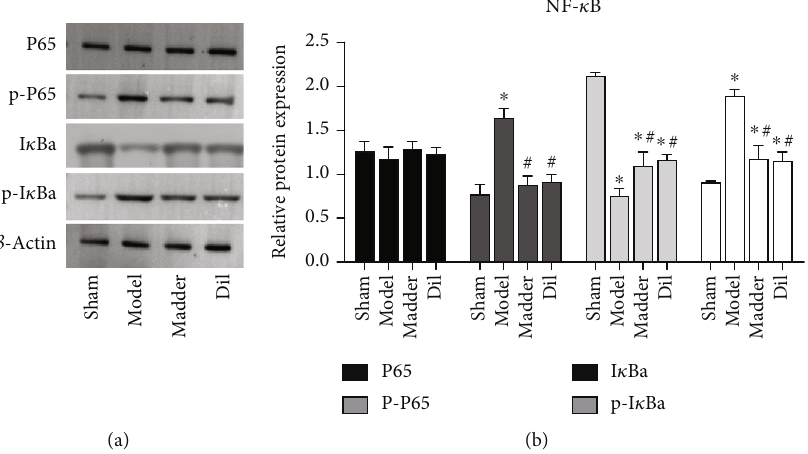
Figure 4: E ff ect of madder treatment on NF- κ B pathway. The expression levels of NF- κ B pathway-related proteins P65, P-P65, I κ Ba, and P- I κ Ba were detected by WB assay. ∗ P < 0 : 05 , compared with the sham group; # P < 0 : 05 , compared with the model